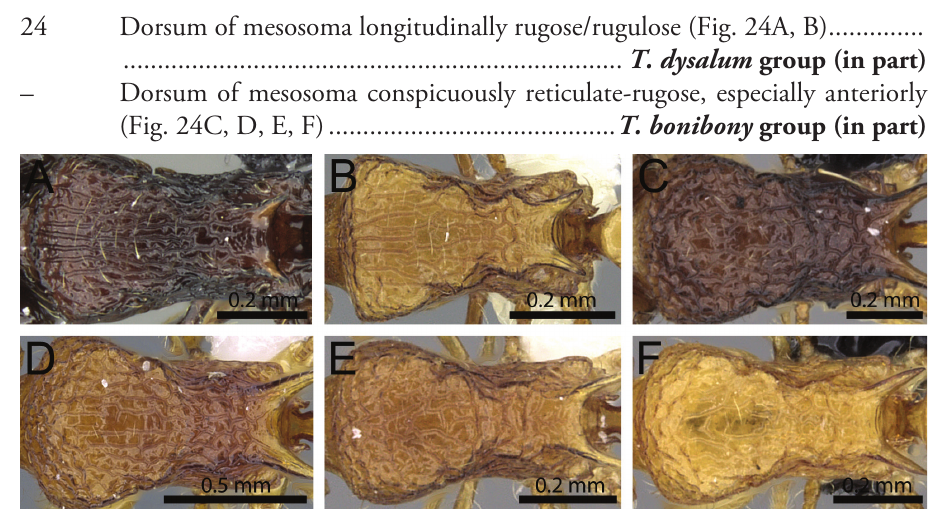
Figure 24. Mesosoma in dorsal view. A T. orc (CASENT0487093) B T. mackae (CASENT0189093) C T. sada (CASENT0443274) D T. vony (CASENT0404310) E T. kali (CASENT0235221) F T. olana